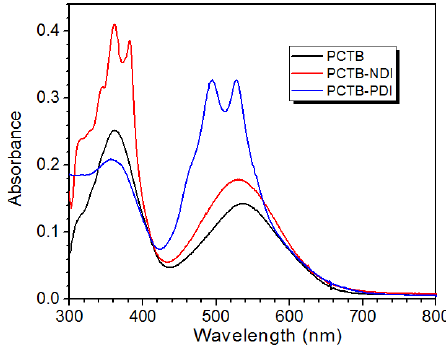
Figure 1. UV-Vis spectra of polymer solutions in CHCl 3 . Table 1. The summary of photophysical, electrochemical, and thermal properties.